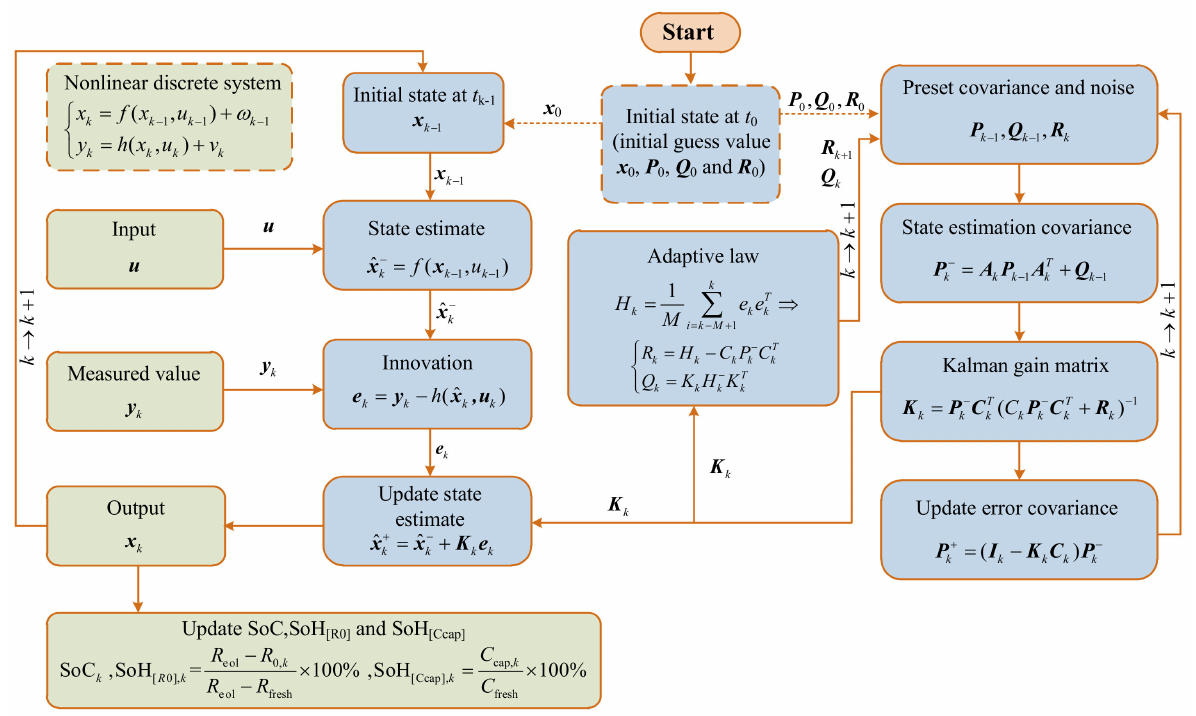
Figure 7. The implementation flowchart of AEKF-based SoC/SoH co-estimation.